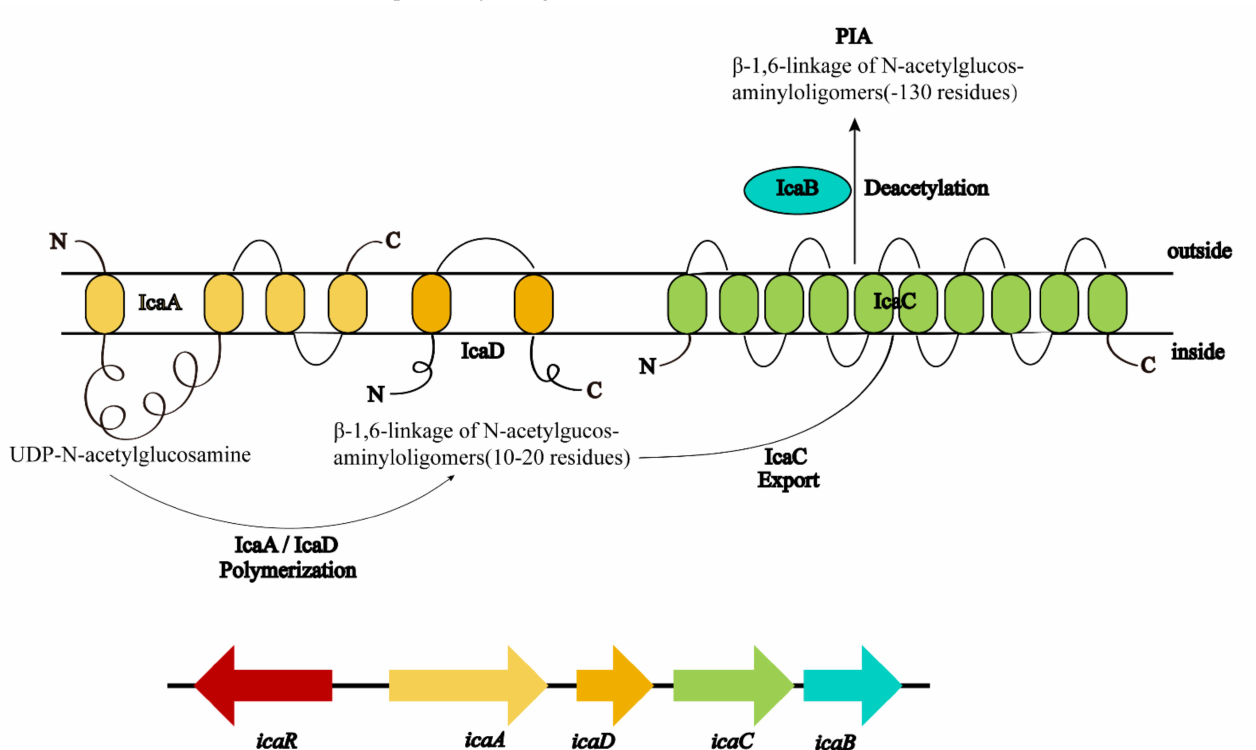
Figure 3. Genetic encoding and biosynthesis of PIA. PIA is synthesized from the product of icaADBC operon. IcaA and IcaD are two membrane proteins that polymerize N-acetylglucosamine from the activated precursor UDP-N-acetylglucosamine monomers. This chain may be exported by the membrane protein IcaC . IcaB is an acetylase attached to the outer surface of bacteria. By deacetylation of residues, IcaB introduces a positive charge into the originally neutral PIA molecule